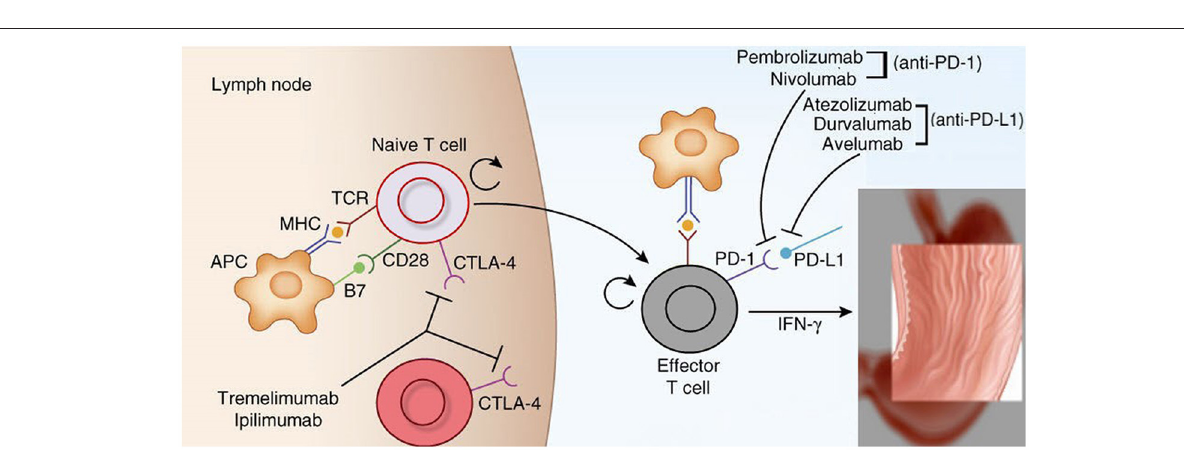
FIGURE 2 | Mechanism of action of cytotoxic lymphocyte associated protein 4 (CTLA-4) and programmed cell death protein 1 (PD-1) and its ligands (PD-L1) (Brahmer et al., 2012; Topalian et al., 2015; Tsai and Hsu, 2017). CTLA-4 plays role in de novo immune stimulation during antigen priming by antigen presenting cells (APCs), macrophages and dendritic cells (DCs). Following antigen exposure, CTLA-4 is expressed on T cells and competes with CD 28 for binding at B7 (B7-1/CD 80 and B7-2/CD 86) on APCs. This generates inhibitory signals for T-cells which shuts off antigen priming by APCs in the tumor draining lymph nodes. CTLA-4 inhibitors namely ipilimumab and tremelimumab restores antigen priming by blocking CTLA-4 on T cells. On the other hand PD-1/PD-L1 axis plays important role in the adaptive resistance by tumors cells against host immune system. PD-1 is expressed on immune cells like T-cells, B-cells and monocytes. The expression of PD-L1 is upregulated on tumor cells and APCs in response to interferon gamma secreted from activated T-cells via activation of JAK2/STAT3 pathway. PDL-2 is also a ligand for PD-1 and is exclusively expressed on DCs. Engagement of PD-L1/L2 by PD-1 inhibits proliferation, migration and effector functions of T-cells. This effect is